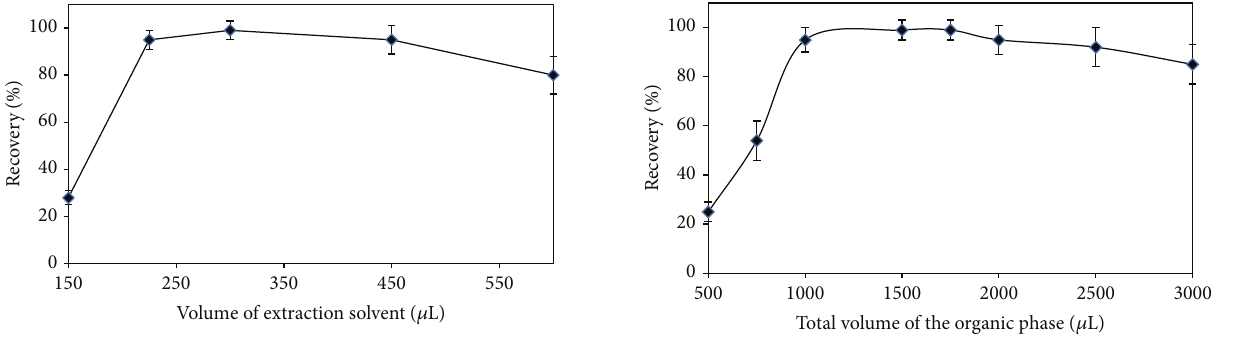
Figure 4: Effect of the total volume of the organic phase on the recovery of bismuth.